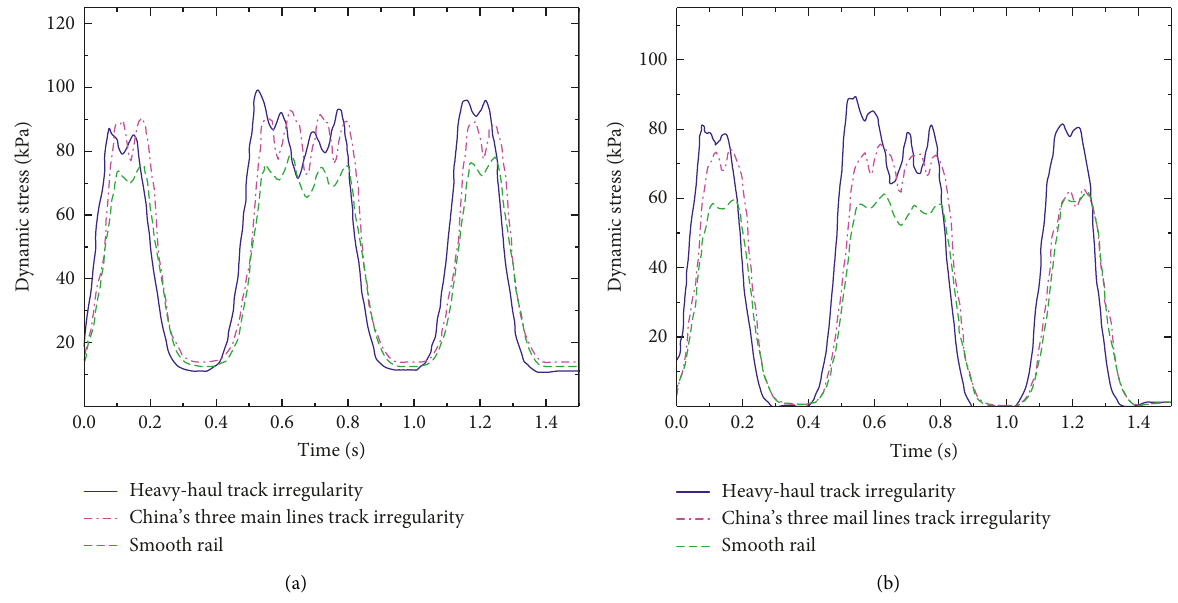
Figure 15: Dynamic stress at the subgrade surface under different irregular track spectra: (a) below rail; (b) below centerline.